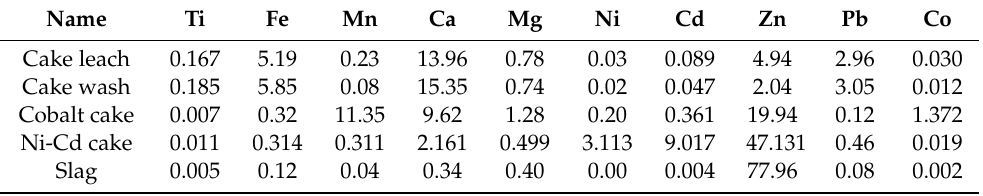
Table 1. Chemical analyses of zinc process residues in %